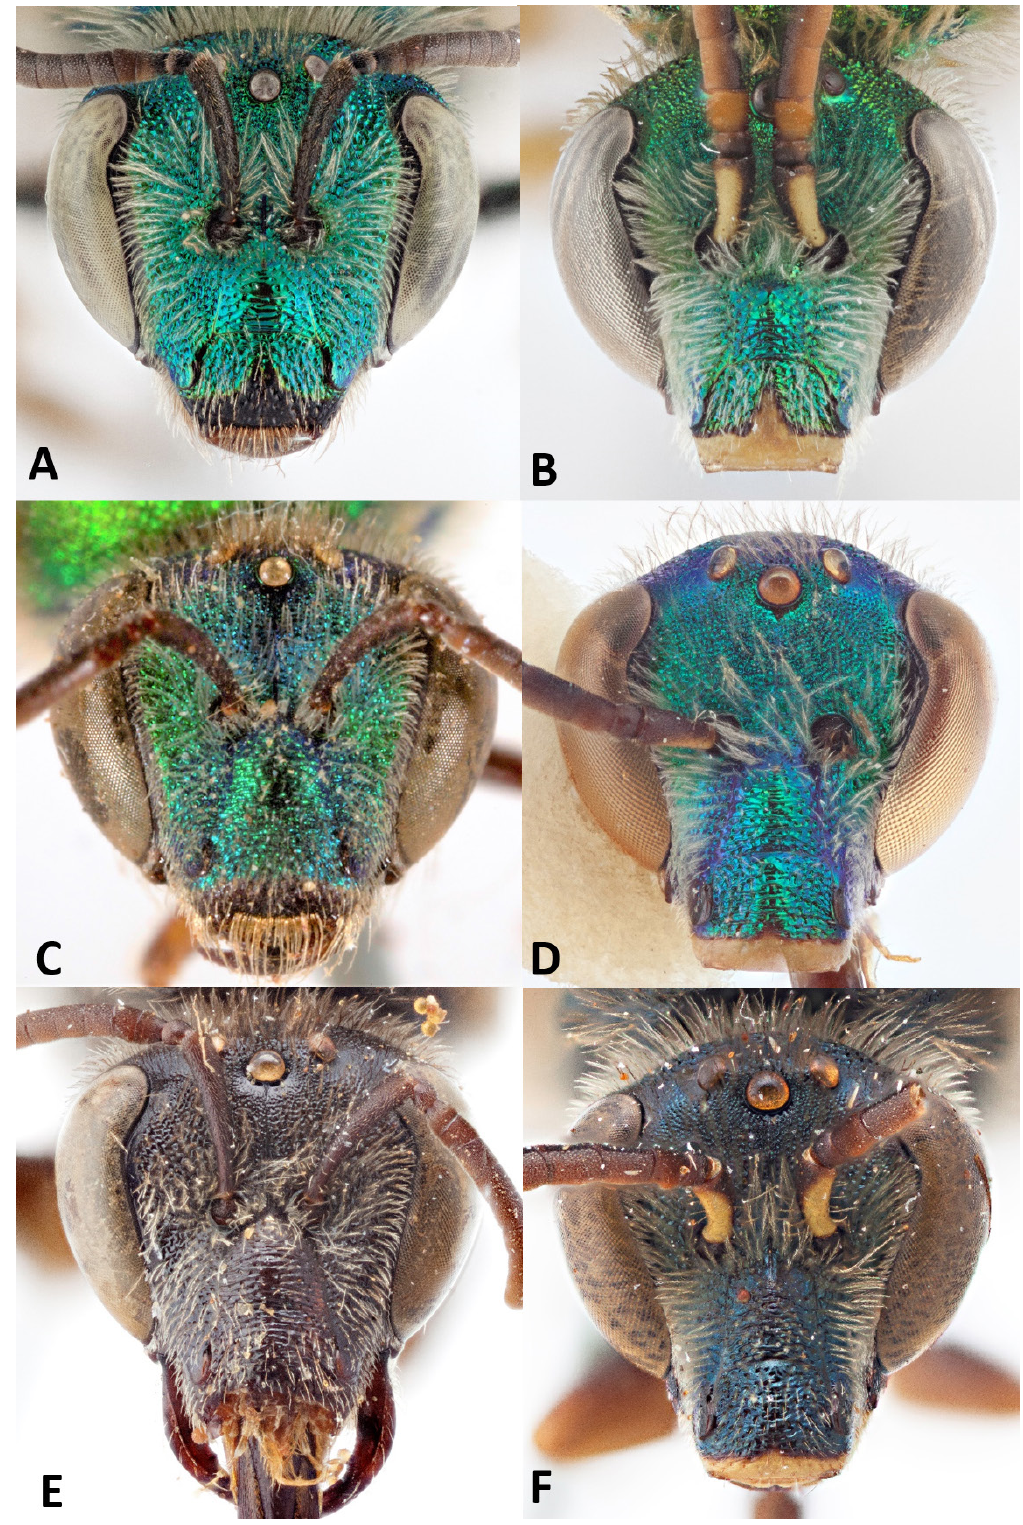
Fig. 7. Face of females (left column) and males (right column). A–B . Agapostemon virescens (Fabricius, 1775). C . Ag. semiviridis Cresson, 1865, lectotype [= Ag. femoralis (Guérin-Méneville,